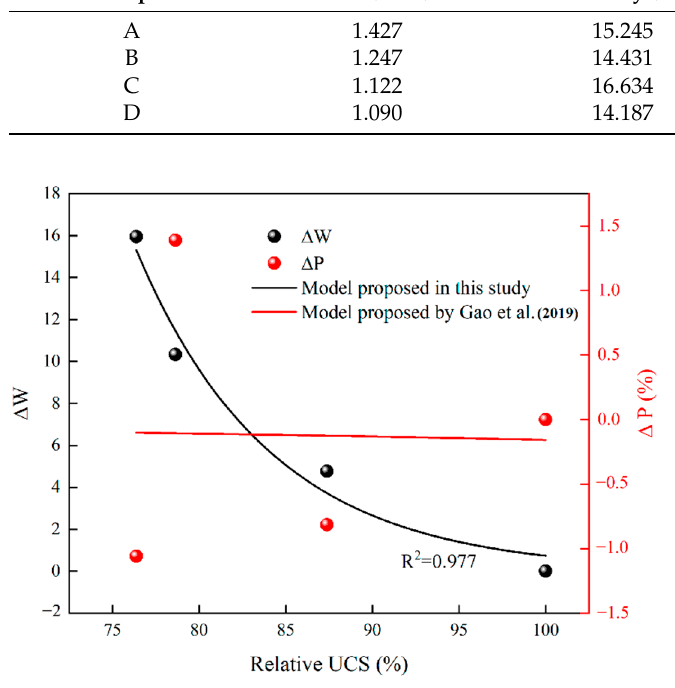
Figure 13. Fitting results using data from Hu et al. [17] and Gao et al. [35].